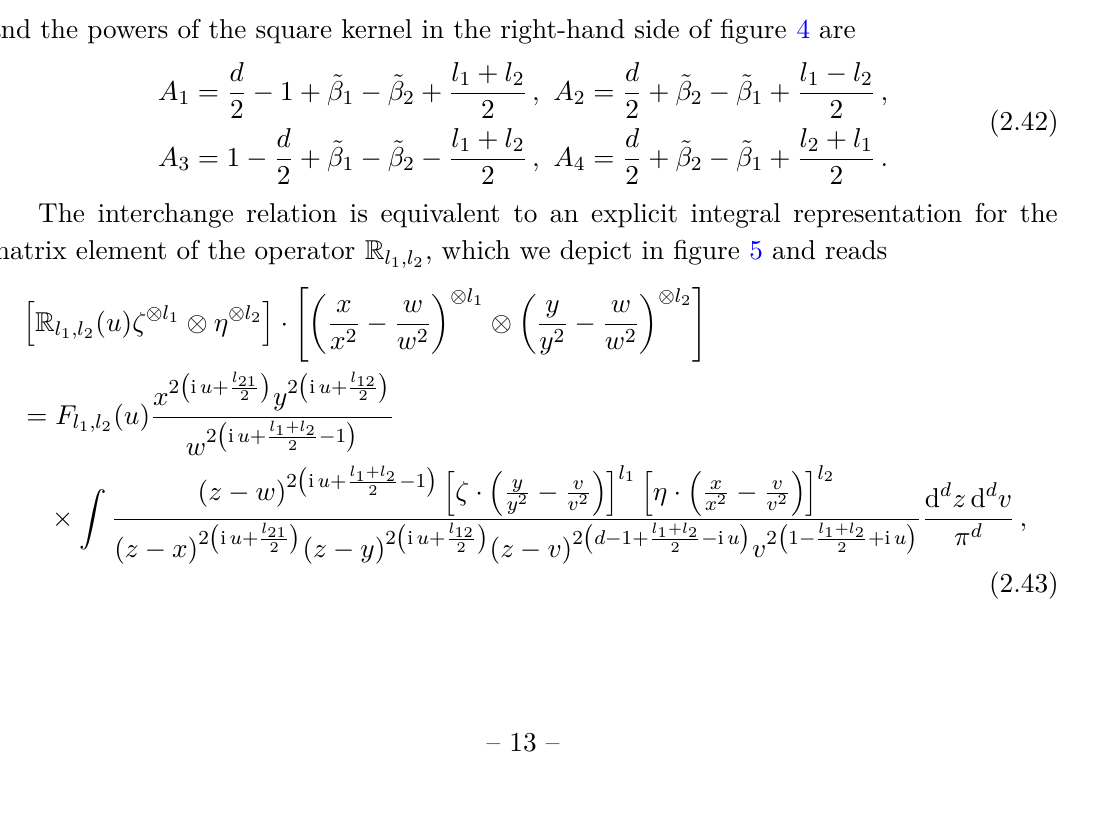
Figure 4 . Graphical representation of the interchange relation. Black dots are integration points of the diagram, circles are external points. The powers a j , b j , c j , d j , for j = 1 , 2 , of the solid lines get exchanged between both sides of the